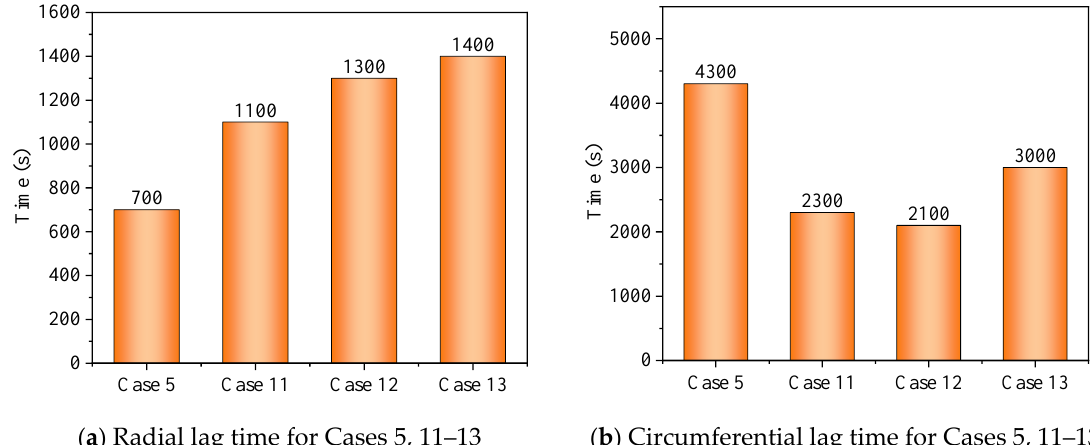
Figure 18. Melting process for Cases 5, 11 – 13.